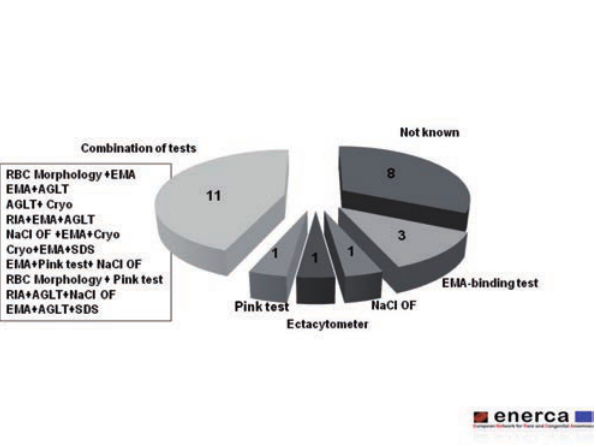
Figure 3. Method considered to have the best specificity and sen- sitivity, as resulted from the ENERCA survey on Diagnosis of RBC membrane disorders , 25 Centres